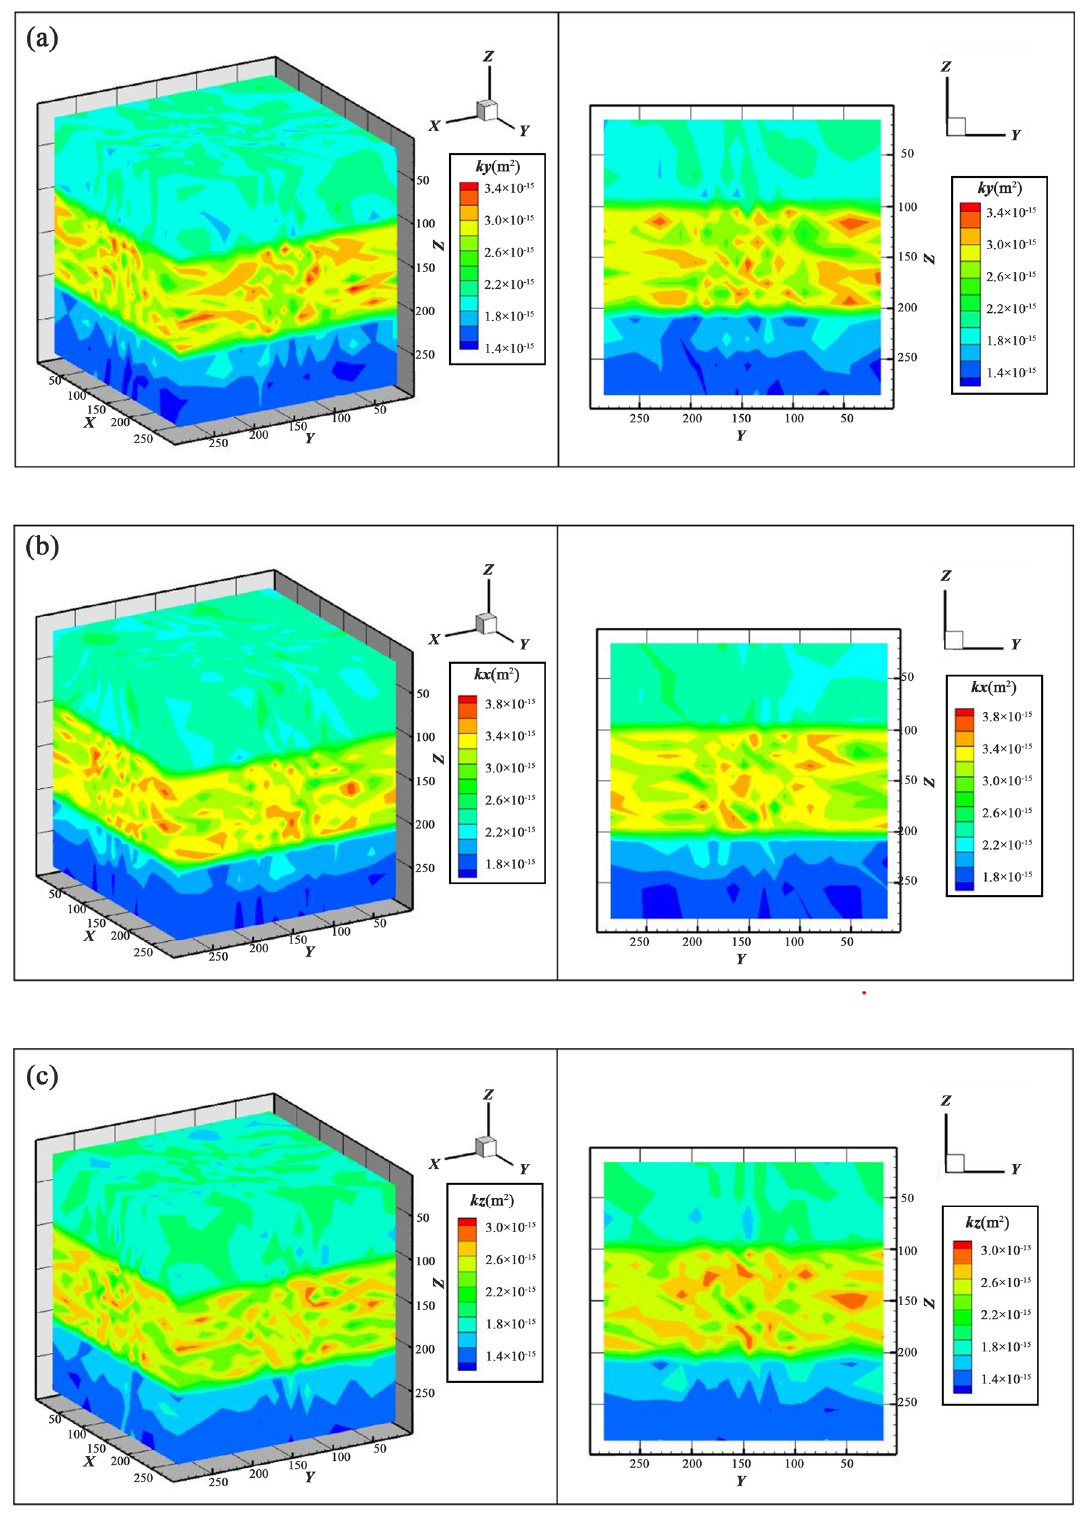
Figure 4. Three ‐ dimensional images display the spatial distribution of initial fracture permeability in the x , y , and z directions,